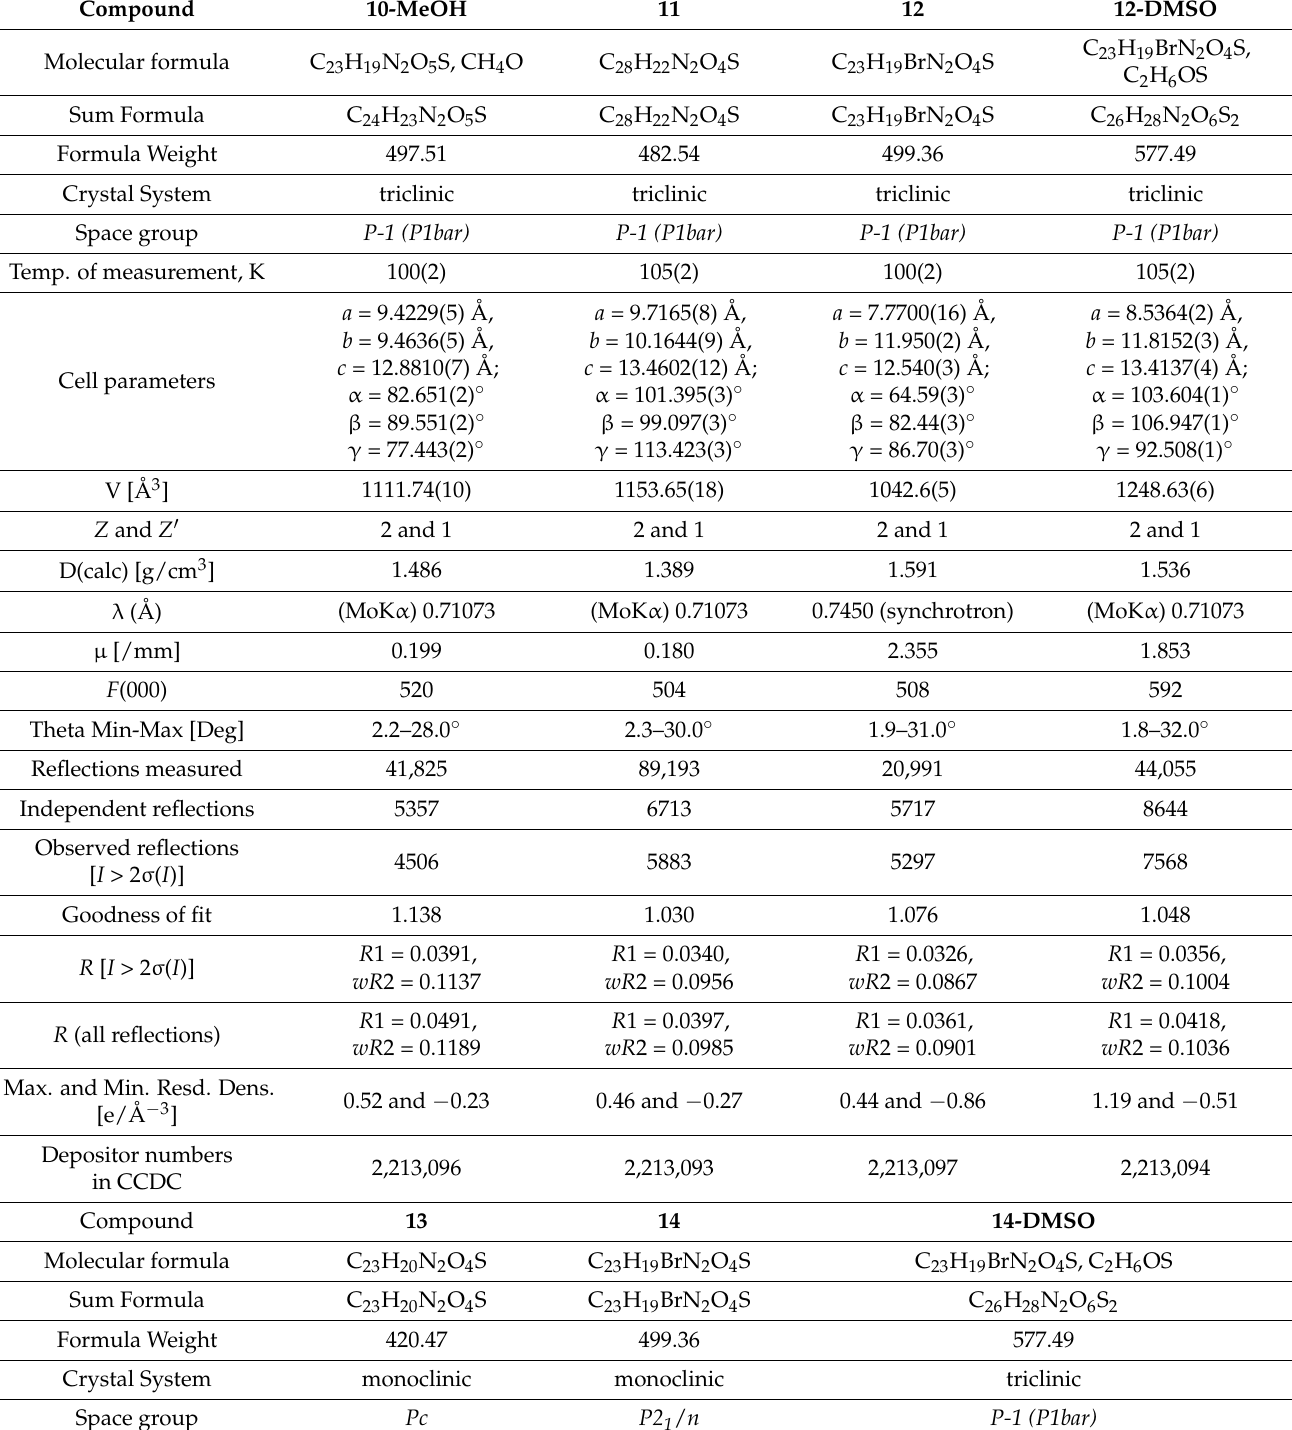
Table 3. Crystallographic data for studied